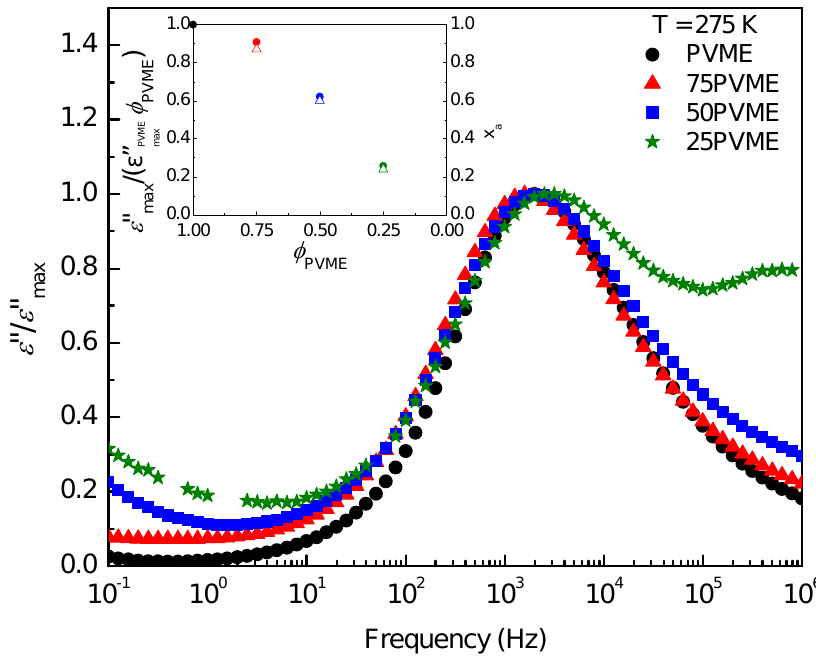
Figure 7. Dielectric loss curves (normalized by the PVME weight fraction φ PVME ), recorded at T = 275 K, on PVME and PVME/SCNP mixtures with φ PVME = 75% (red), 50% (blue), and 25% (green). Inset: Maxima of the loss peak, ε (cid:48)(cid:48) max (divided by the PVME weight fraction φ PVME ), as a function of the PVME weight